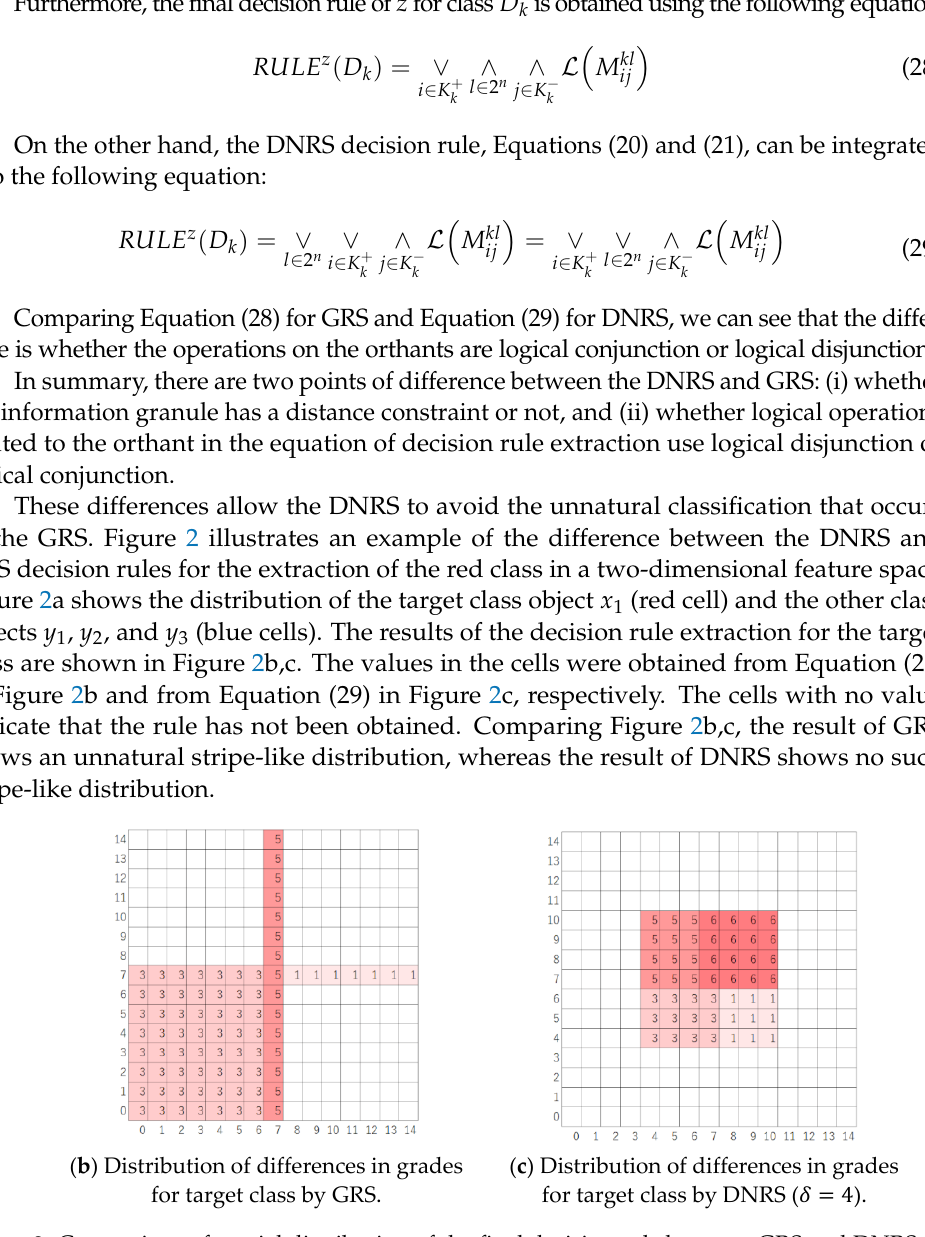
Figure 2. Comparison of spatial distribution of the final decision rule between GRS and DNRS in two-dimensional feature space. The vertical and horizontal axes in this figure show the feature space with the grade multiplied by 100, and a part of the feature space is expanded. And the grades in difference in cells are also multiplied by 100.